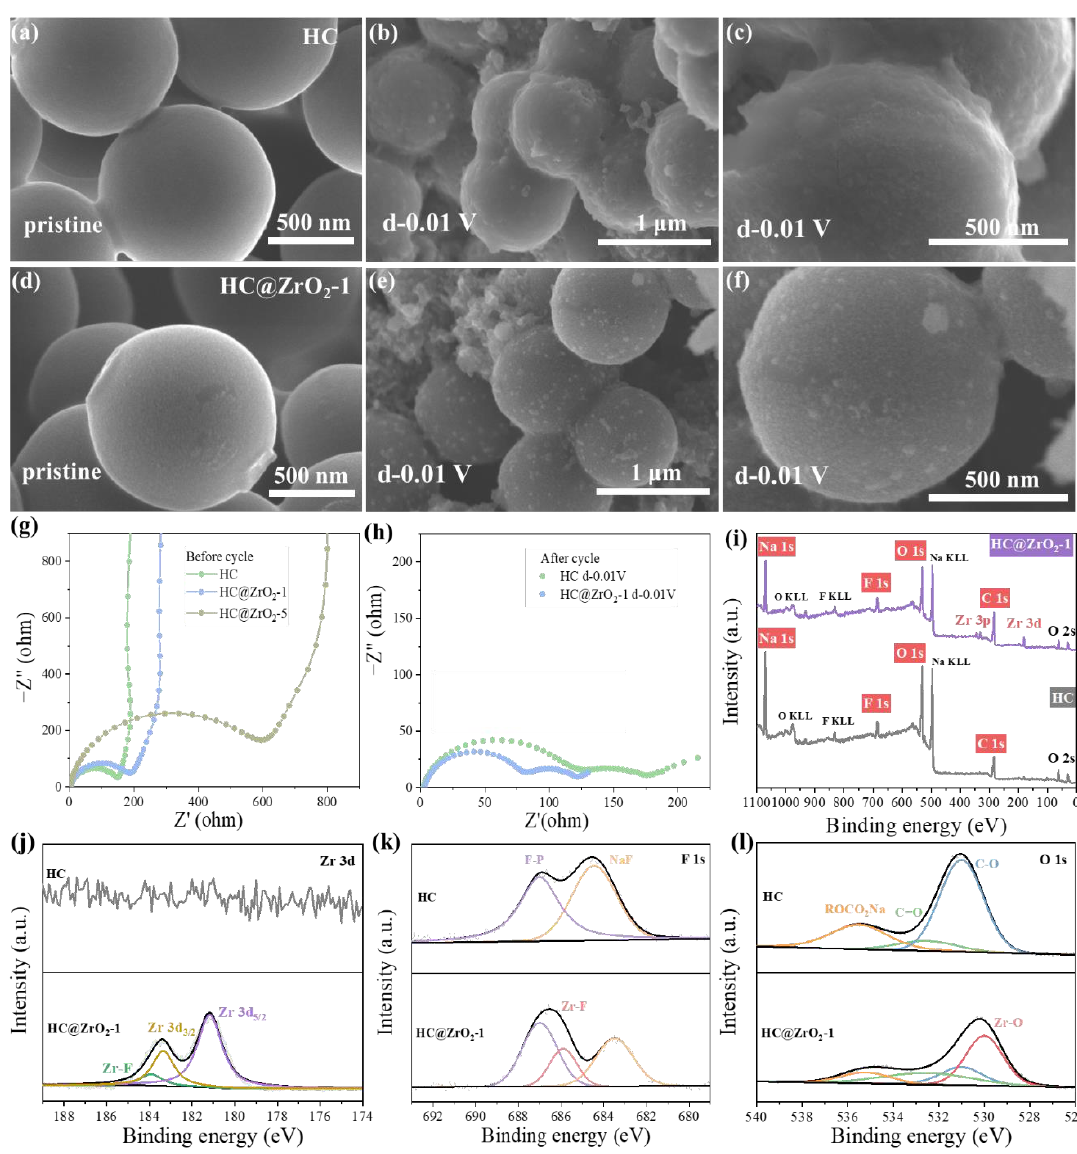
Figure 4. SEM images of HC ( a – c ) and HC@ZrO 2 -1 ( d – f ) electrodes discharged to 0.01 V (d-0.01 V). ( g ) EIS plots of HC||Na and HC@ZrO 2 ||Na half cells at initial open circuit voltage state; ( h ) EIS plots of HC and HC@ZrO 2 -1 electrodes with the three-electrode setup at fully discharged state (d-0.01 V). XPS full spectra ( i ), the high-resolution Zr 3d ( j ), and the high-resolution F 1s ( k ) and O 1s ( l ) spectra of HC and HC@ZrO 2 -1 electrodes discharged to 0.01 V.